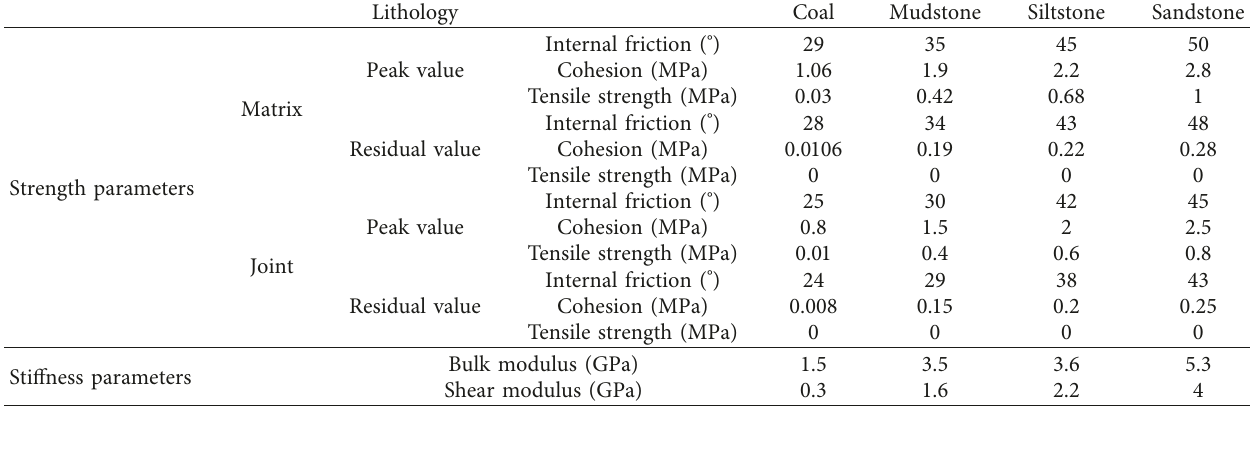
Table 2: Mechanical parameters of